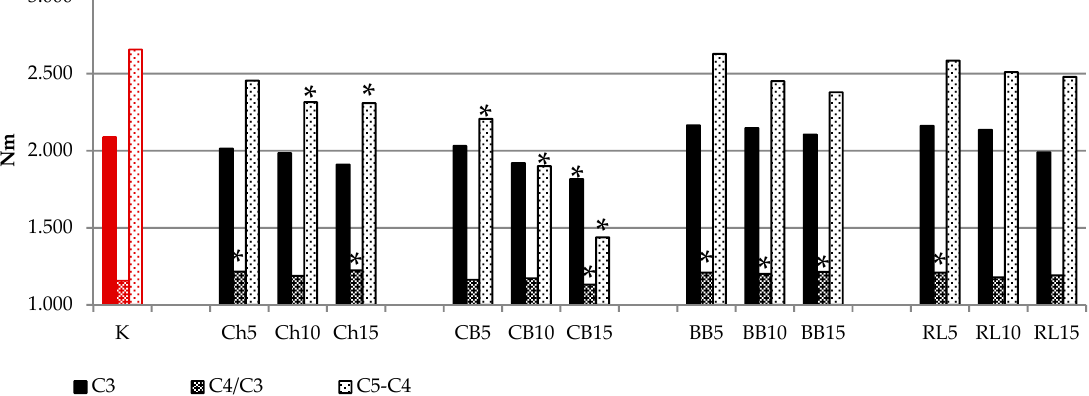
Figure 2. Influence of legume flour addition on torque for starch gelatinization (C3), cooking stability (C4/C3 value) and resistance to retrogradation (C5-C4 value). * values are significantly different ( p < 0.05) compared to control. K = WF(50) + RF(50); Ch5 = WF(50) + RF(45) + ChF(5); Ch10 = WF(50) + RF(40) + ChF(10); Ch15 = WF(50) + RF(35) + ChF(15); CB5 = WF(50) + RF(45) + CBF(5); CB10 = WF(50) + RF(40) + CBF(10); CB15 = WF(50) + RF(35) + CBF(15); BB5 = WF(50) + RF(45) + BBF(5); BB10 = WF(50) + RF(40) + BBF(10); BB15 = WF(50) + RF(35) + BBF(15); RL5 = WF(50) + RF(45) + RLF(5); RL10 = WF(50) + RF(40) + RLF(10); RL15 = WF(50) + RF(35) + RLF(15).